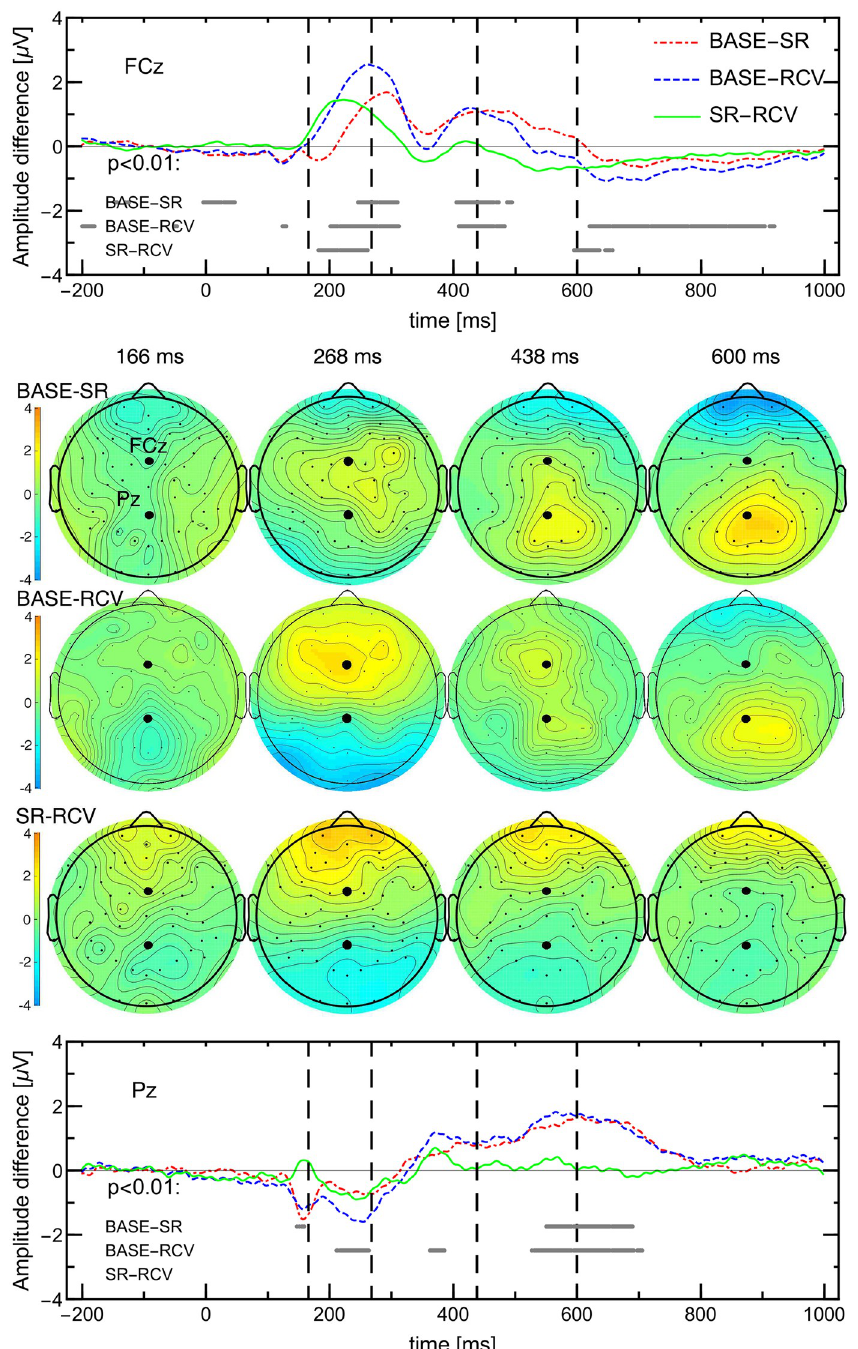
Fig 5. Differences in ERP amplitudes between BASE, SR (days 10–14), and RCV periods, derived from Fig 4 (note that the scale is twice as small as therein). Grey lines in the lower part indicate time points at which t-tests for pairwise comparisons yielded p-value p < 0.01. SR and RCV only differ frontally in early processing, whereas they diverge from BASE in frontocentral and parietal areas for extended intervals. The differences around 268 ms can be attributed to latency